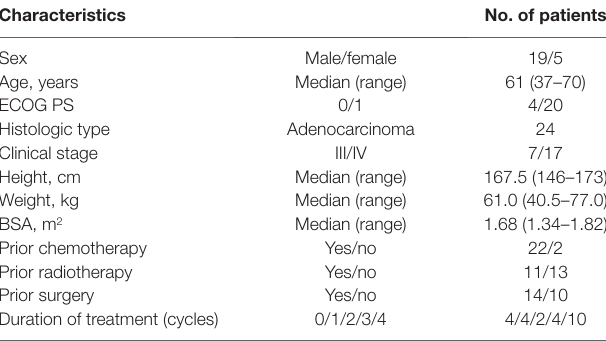
FIGURE 2 | Mean plasma vinorelbine concentration vs time curves after receiving ANX and Navelbine.